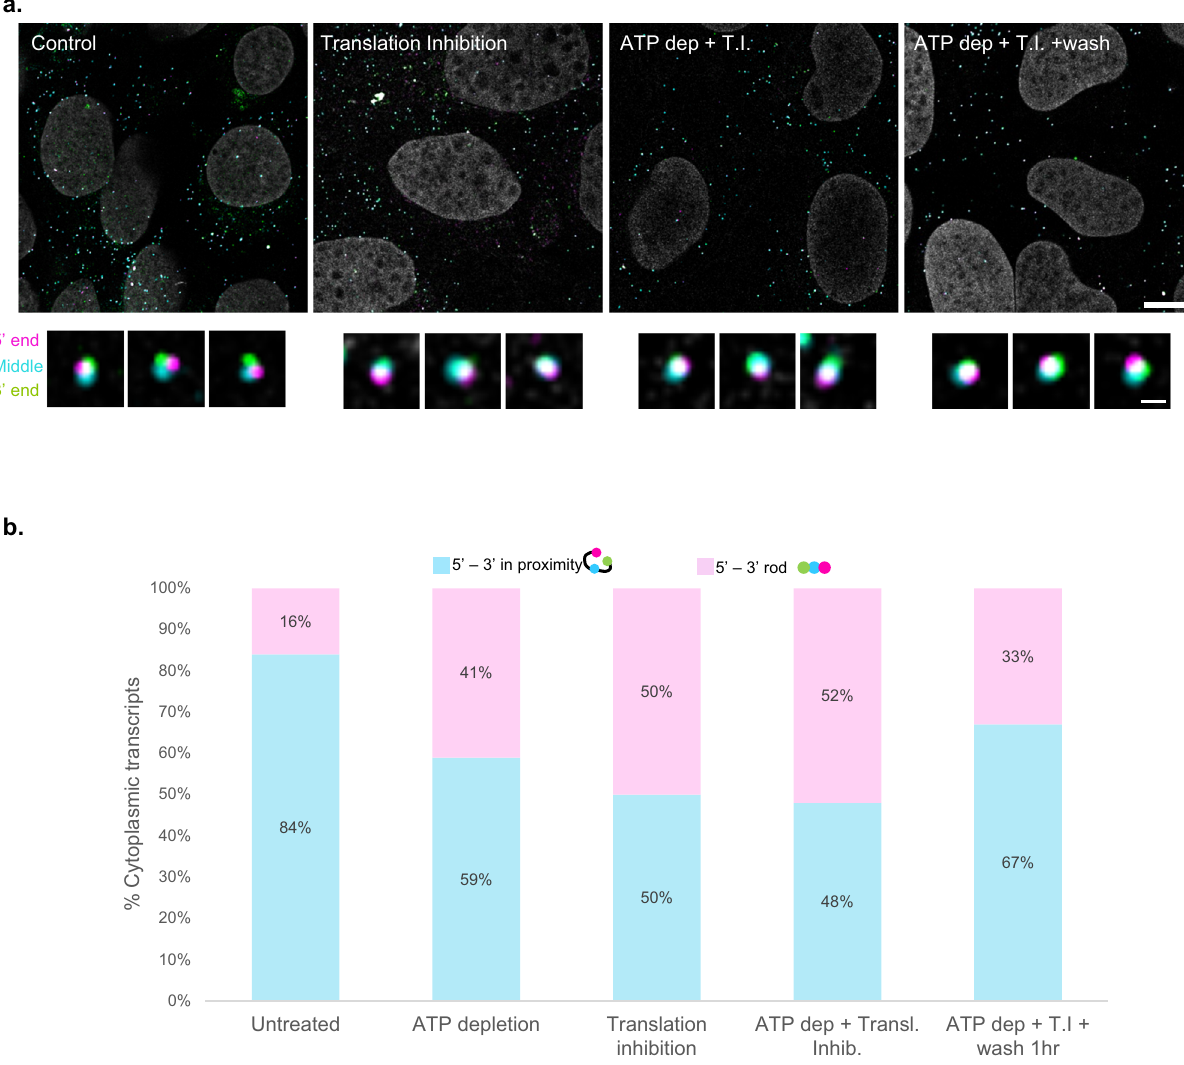
and 3 ’ -ends of triple-tagged MKI67 transcripts in the U2OS cytoplasm, under var- ious treatments. Untreated n =158, ATP depletion n =124, translation inhibition n =100, translation inhibition+ATP depletion n =131, translation